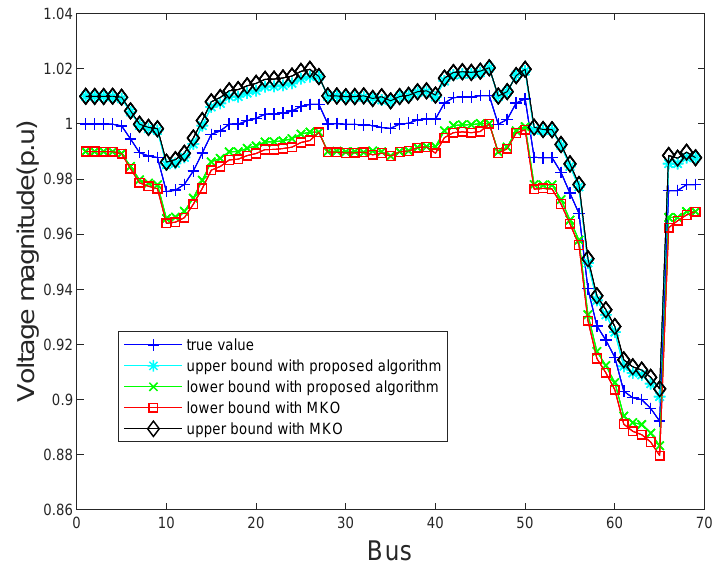
Figure 5. The estimated bus voltage magnitudes obtained by the proposed algorithm and MKO on the IEEE 69 bus system.